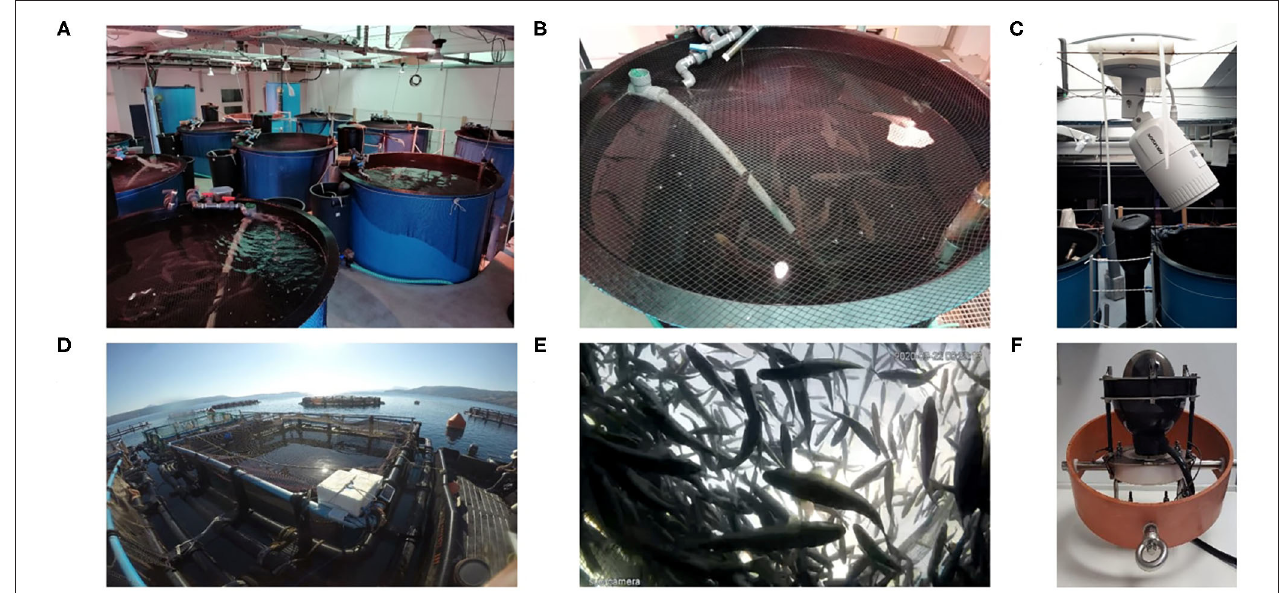
FIGURE 1 | The RAS (A–C) and sea cage (D–F) aquaculture facilities and network cameras (C,F) used at